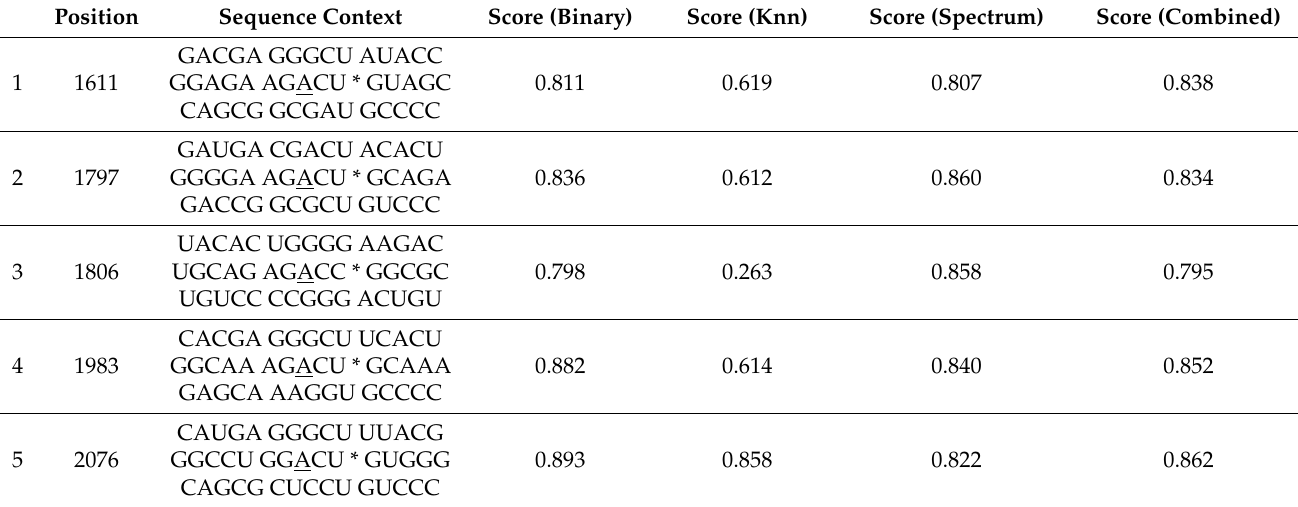
Table 1. The predicted m 6 A sites of TNC mRNA in mice by